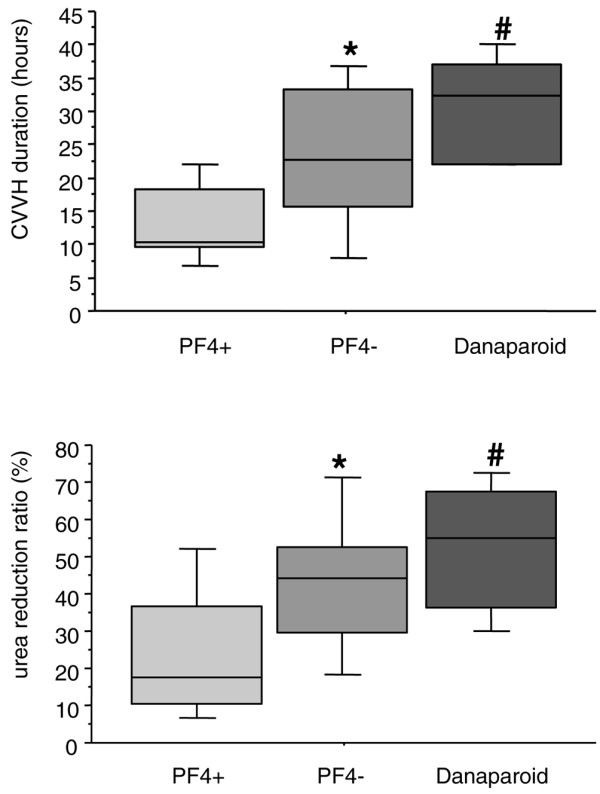
Duration and efficiency of continuous veno-venous hemofiltration (CVVH) sessions. Boxes represent medians, interquartile ranges, and 10th and 90th percentiles of mean duration of CVVH sessions (upper panel) and urea reduction ratios ([(urea before – urea after)/urea before] × 100, lower panel) observed in PF4+ (n = 7) and PF4- (n = 21) patients when using unfractionated heparin (50 and 132 sessions for PF4+ and PF4- patients, respectively) and in PF4+ patients when using danaparoid sodium for anticoagulation (17 sessions). *P < 0.05 compared with PF4+ (using a Mann-Whitney test); #P = 0.027 compared with PF4+ (using a Wilcoxon rank test). There was no difference between PF4- and danaparoid CVVH durations (P = 0.17) or urea reduction (P = 0.27). PF4-, anti-PF4/heparin antibody-negative; PF4+, anti-PF4/heparin antibody-positive.